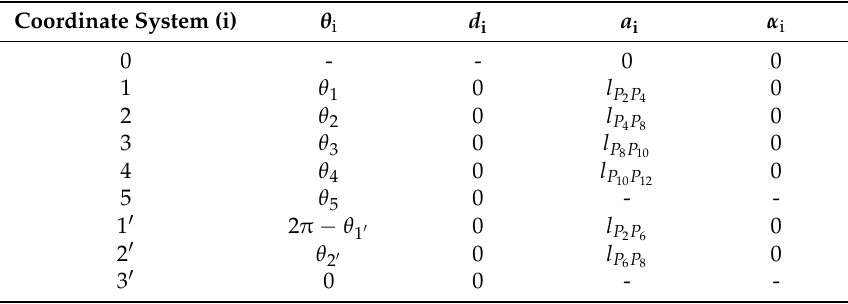
Table A1. D-H parameter table of the main and secondary